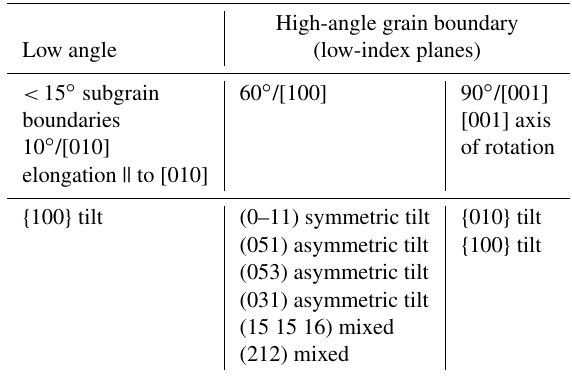
Table 2. Summary of the most common types of grain boundaries in natural and synthetic polycrystalline olivines (compilation based on Demouchy et al., 2014; Marquardt et al., 2015; Marquardt and Faul, 2018; Bollinger et al., 2019; Gasc et al.,